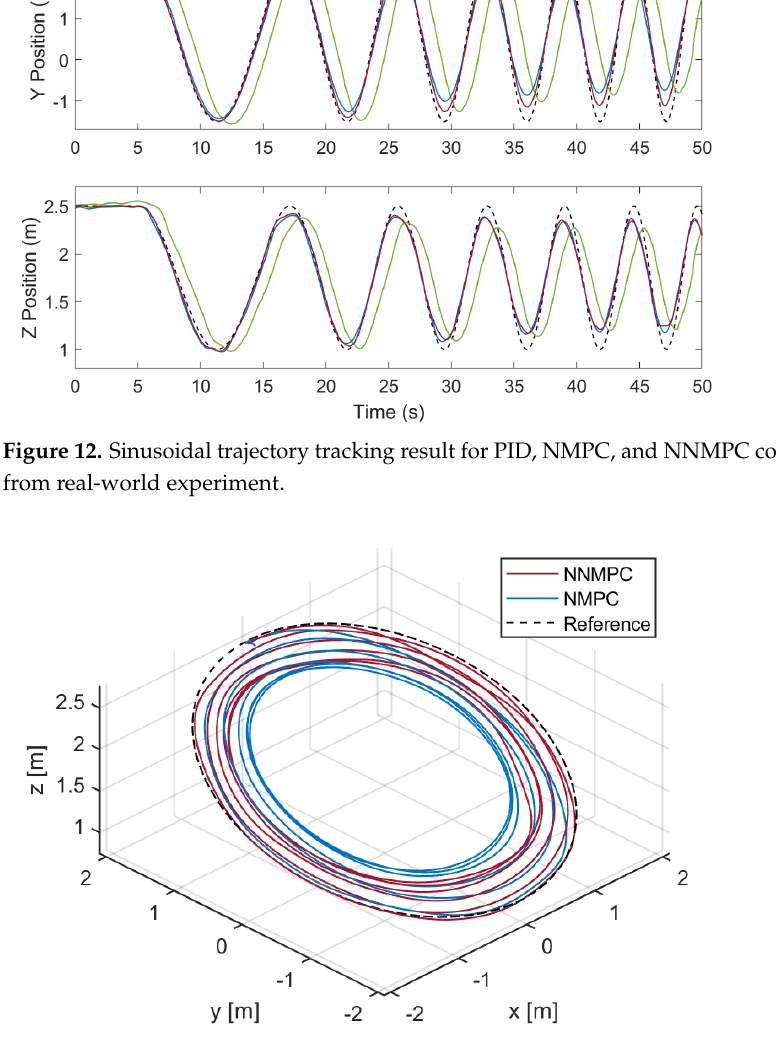
Figure 13. 3D view of the sinusoidal trajectory tracking result for NMPC and NNMPC in flight